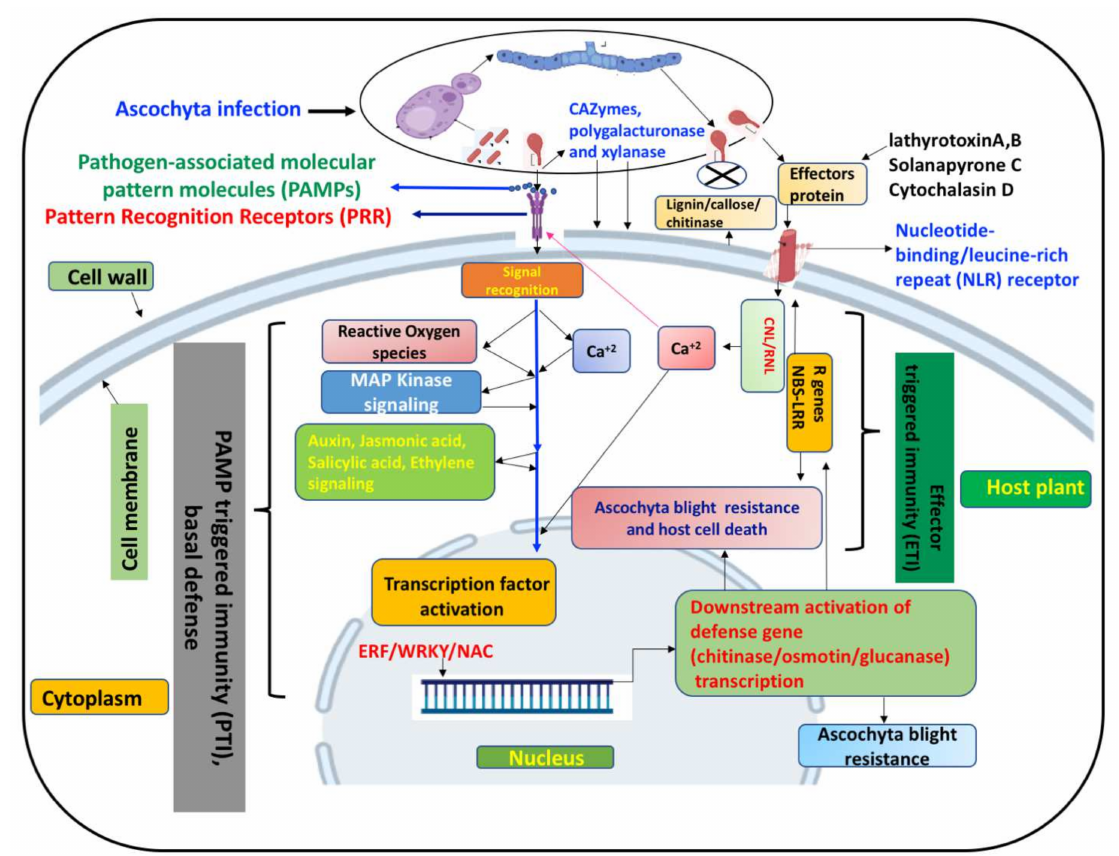
Figure 1. Proposed mechanism of Ascochyta blight (AB) resistance in grain